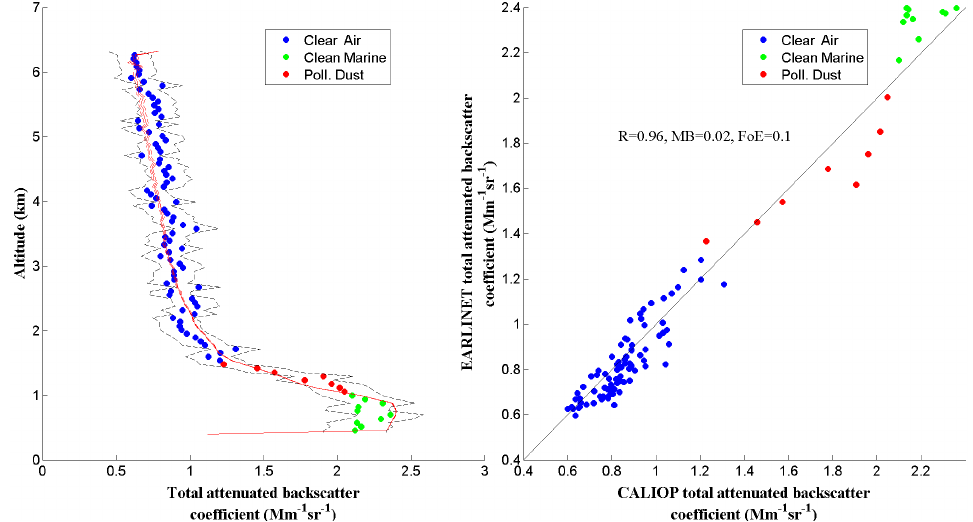
Figure 2. Left panel: attenuated backscatter versus altitude for a CALIOP overpass at Barcelona station on 20 September 2011 at 02:00UTC at 77.9km distance from the station (the red line shows the EARLINET attenuated backscatter profile, the red dashed lines show EARLINET uncertainties, the dots represent CALIOP data, and the black dashed lines show the CALIOP uncertainties); right panel: corresponding scatter plot of CALIOP attenuated backscatter (different colours represent different detected aerosol type; see legend) against EARLINET attenuated backscatter with a 1 : 1 reference line (black).